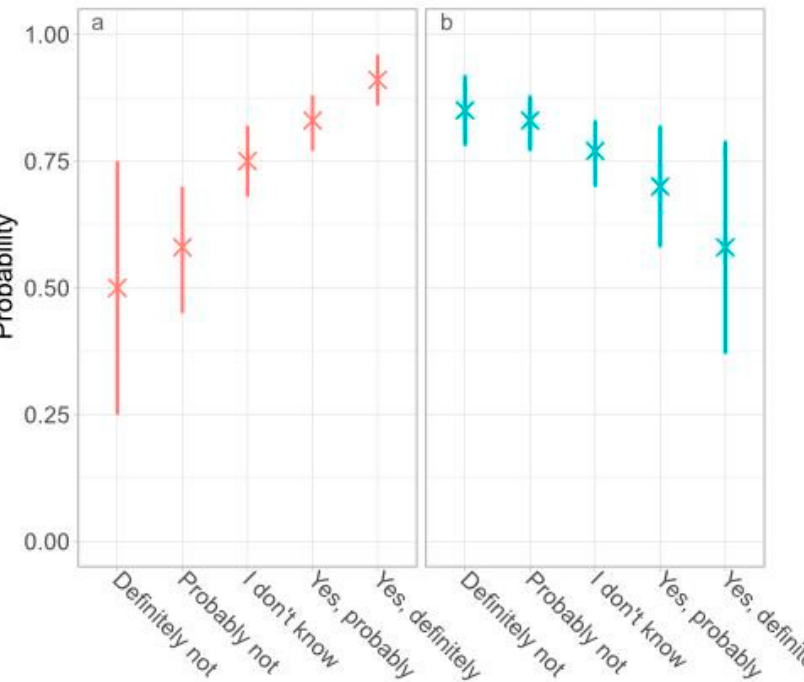
Figure 3. Mitigation by the experience of climate change. Estimated probability of decision-making favouring mitigation of climate change by the strength of belief that one has experienced impacts of climate change: ( a ) negative experience (Bayesian robust correlation ( ρ = 0.95; 98.9% probability of a positive correlation) and ( b ) positive experience (Bayesian robust correlation ρ = − 83.9; 96.9% probability of a negative correlation) of climate change impacts (Q3, Q4, and Q8 in Table 1).